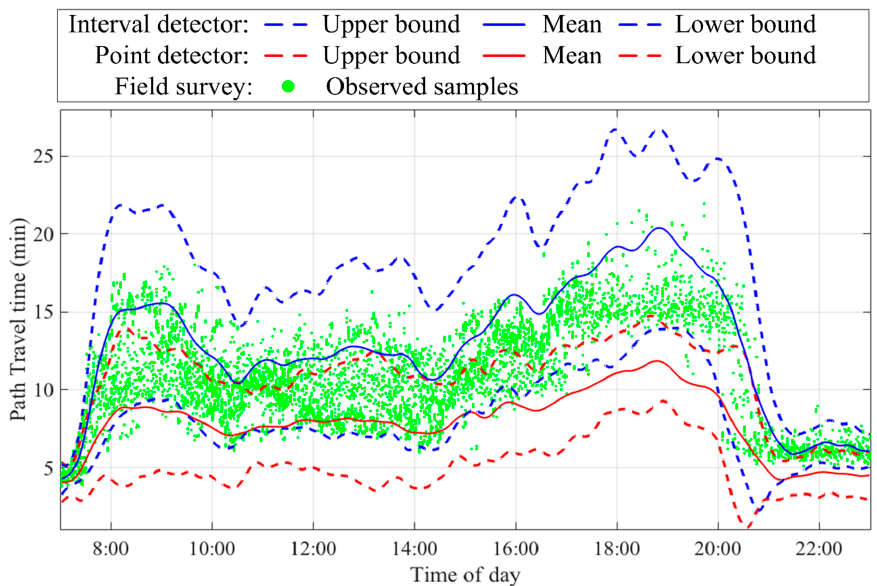
Figure 5. Two path travel time distributions obtained in the data preprocessing step. Sensors 2017 , 17 , 2822